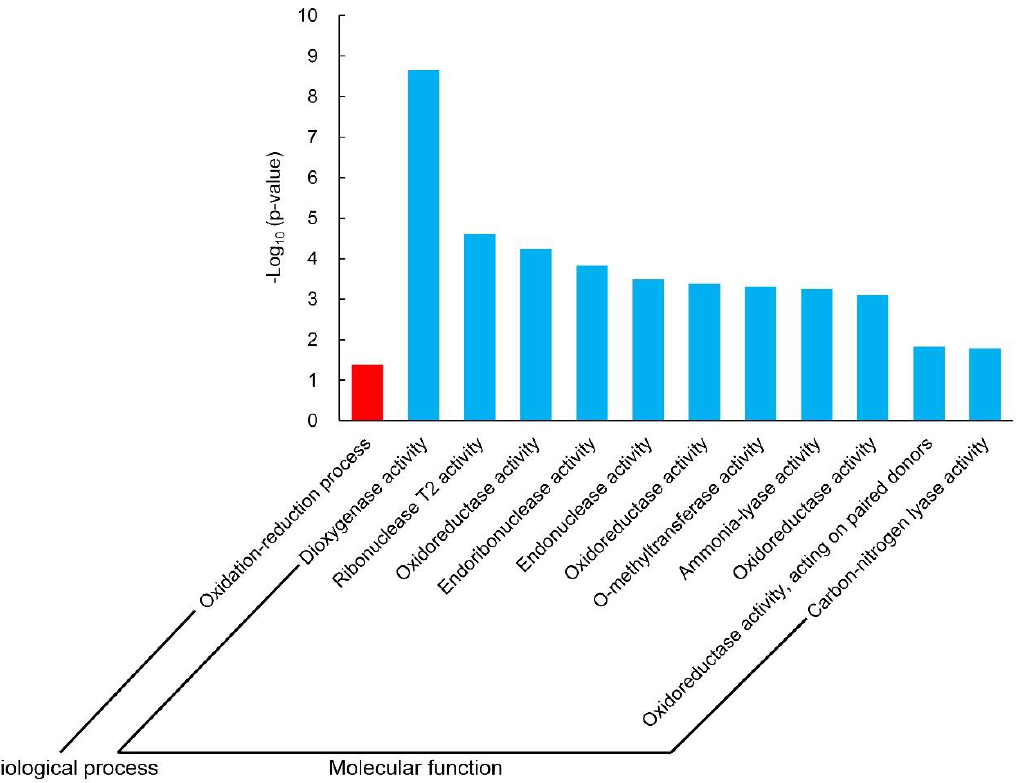
Figure 3. Significantly enriched Gene Ontology (GO) terms ( p < 0.05) analysis in EB36 vs. EA36. EB36